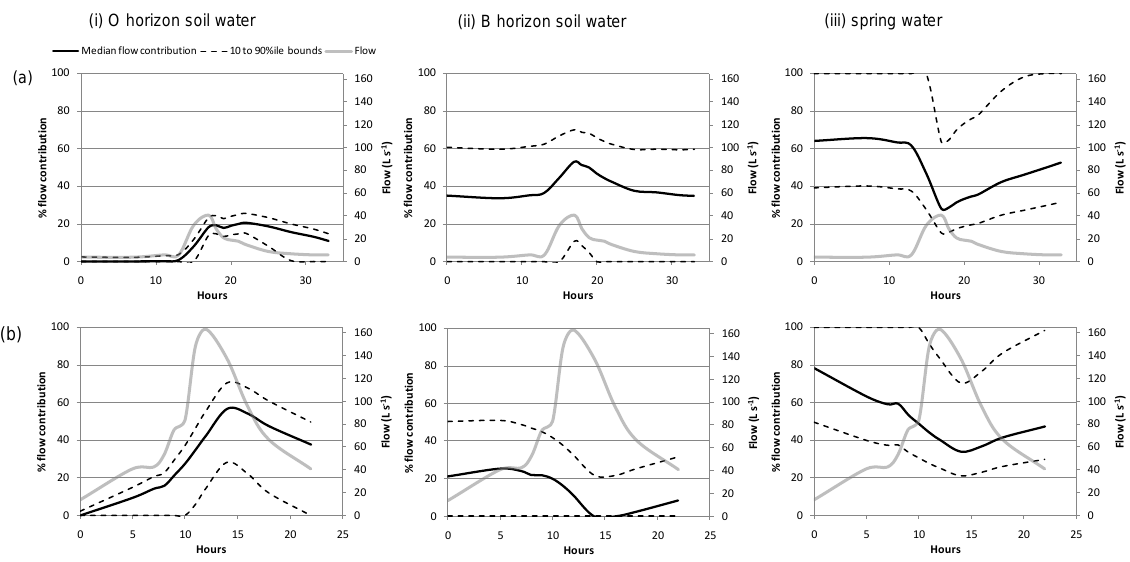
Fig. 7. End-member mixing analysis derived contributions of water flow paths to stream flow for storms in (a) August-2005 and (b) November-2006. Percentage flow contributions are given for (i) O and (ii) B horizon soil waters, and (iii) spring water. Estimations of uncertainty are given as 10 and 90 percentile bounds.